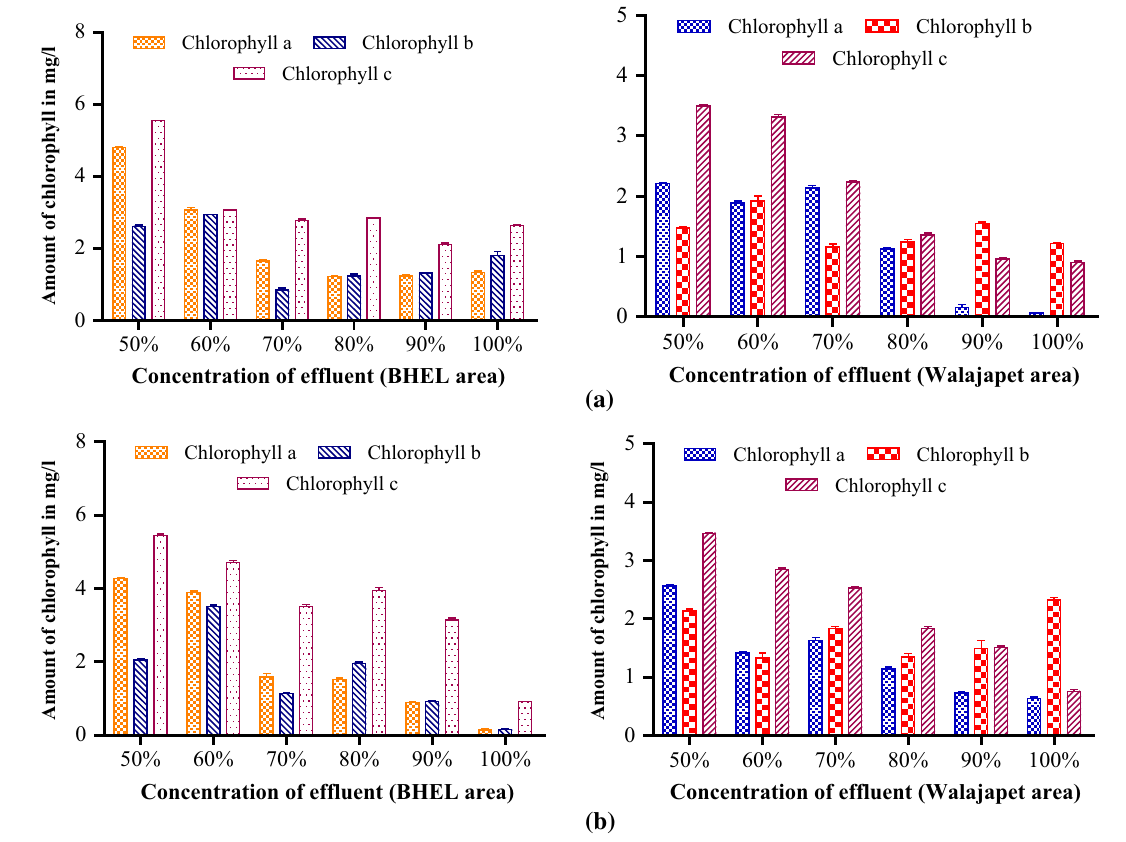
Fig. 6 Chlorophyll content of biomass treated effluent on a Chlorella sp. SRD3 and b Oscillatoria sp. SRD2